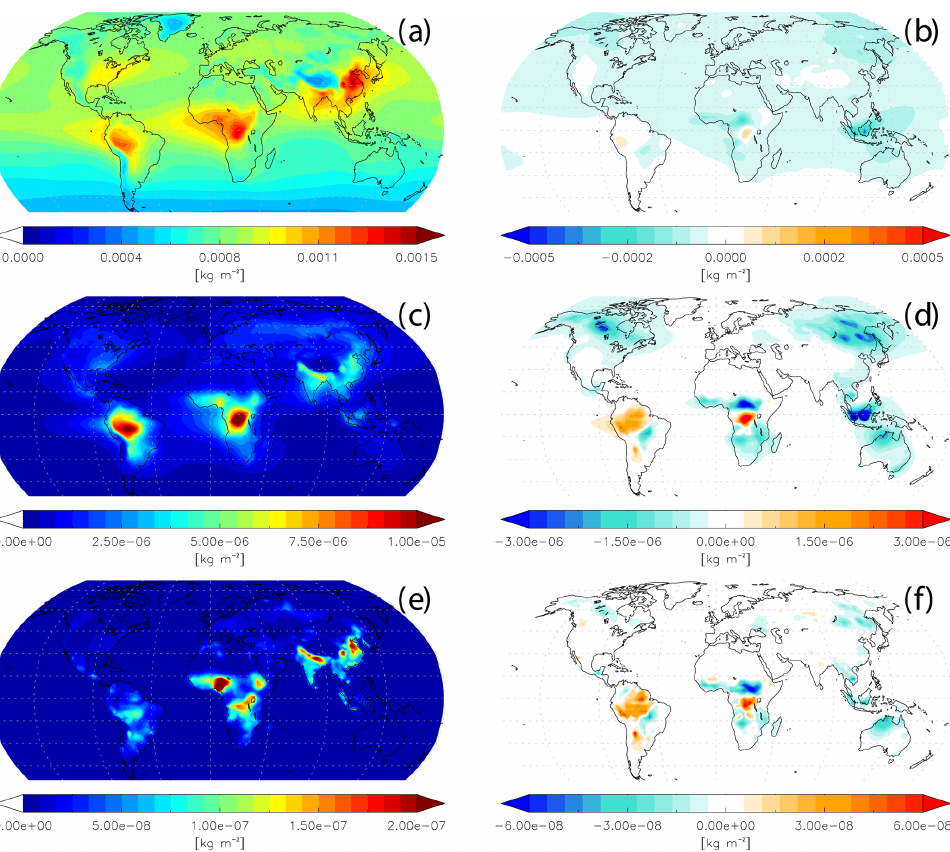
Figure 9. Modeled annual mean column density using pyrE fire emissions (a, c, e) and the difference in column densities with a simulation using offline GFED4s emissions (pyrE – GFED4s; b, d, f ). CO (a, b) , OA (c, d) , and BC (e, f) . Data based on an ensemble of 10